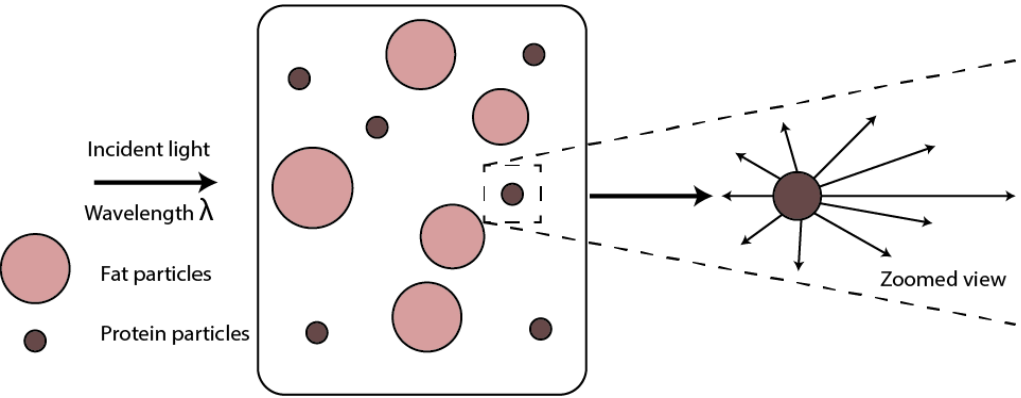
Figure 1. Scatter light effects generated by fat and protein particles. The incident wavelength is smaller than the diameter of both particles. In the zoomed view, the anisotropic Mie scattering is represented.